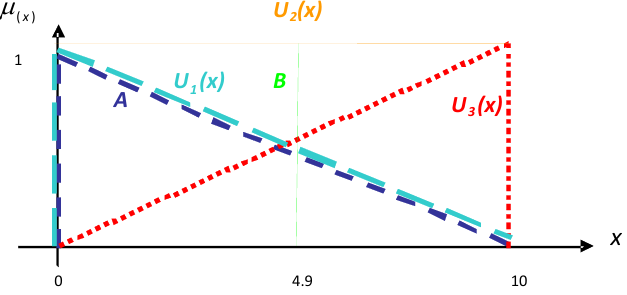
Fig. 5. Comparison of fuzzy numbers A=(0,0,10) and B=(4.9,4.9,4.9) based on descending, constant and ascending linear utility functions